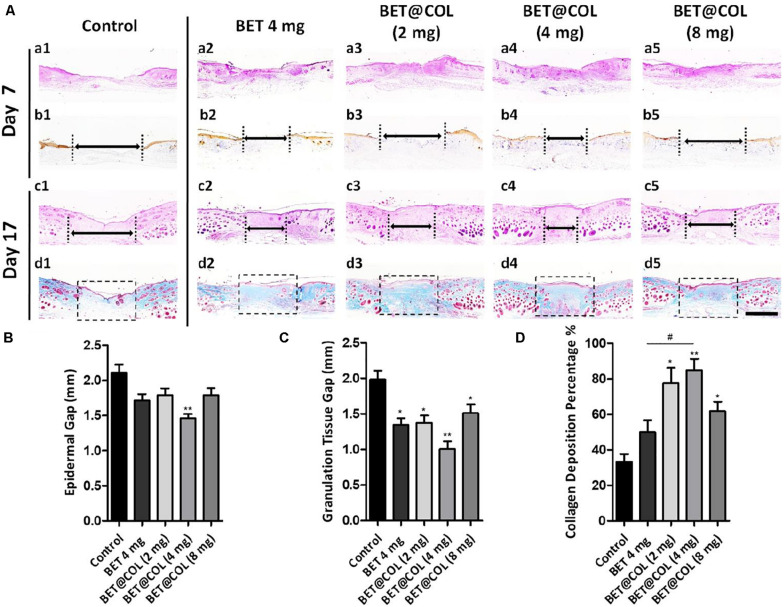
Histological analysis of wound sections on days seven and 17 post treatment. (A) (a1–a5, c1-c5) Representative pictures of H&E (Hematoxylin and Eosin) staining of the control, free betaine solution treated and the BET@COL treated wound tissue sections on day seven and day 17. (b1–b5) Immunohistochemical staining of cytokeratin of the groups mentioned above on day seven. (d1–d5) Masson’s trichrome staining of the groups mentioned above on day 17. Double-headed arrows indicated an epidermal gap (b1–b5) or granulation tissue gap (c1–c5). Dotted boxes indicated collagen deposition sites (d1–d5). Scale bar is 1 mm. (B) Length of epidermal gap on day seven, n > 3. (C) Granulation tissue gap on day 17, n > 3. (D) Collagen deposition percentage on day 17, n > 3. BET, betaine; COL, collagen. Statistical differences were performed using ANOVA. **p < 0.01, *p < 0.05, compared to control group, #p < 0.05.